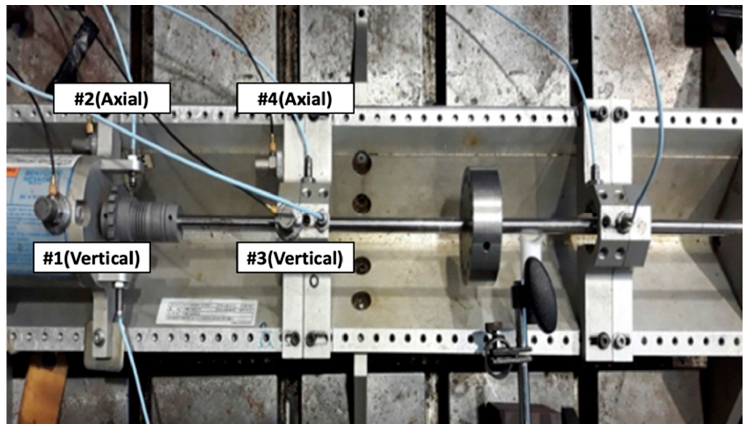
Figure 2. Measurement of experiment system.